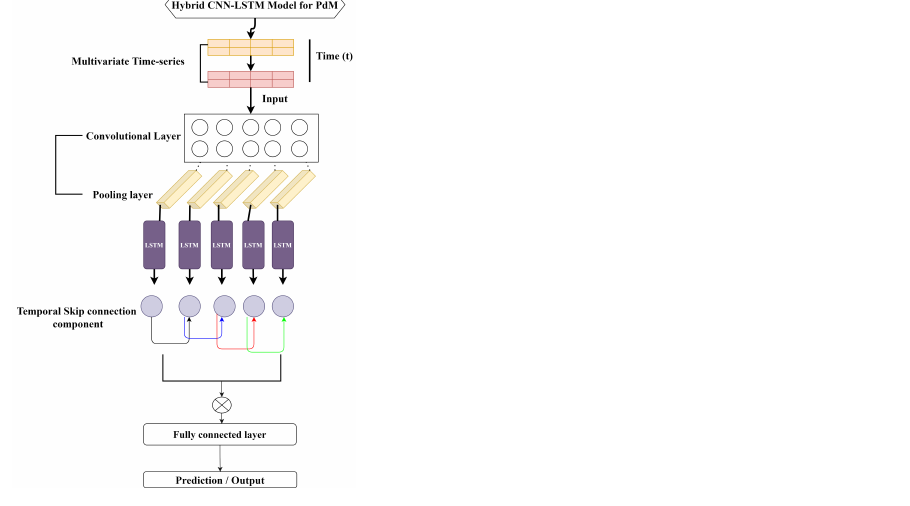
Figure 4. Illustration of proposed hybrid CNN-LSTM model for predictive